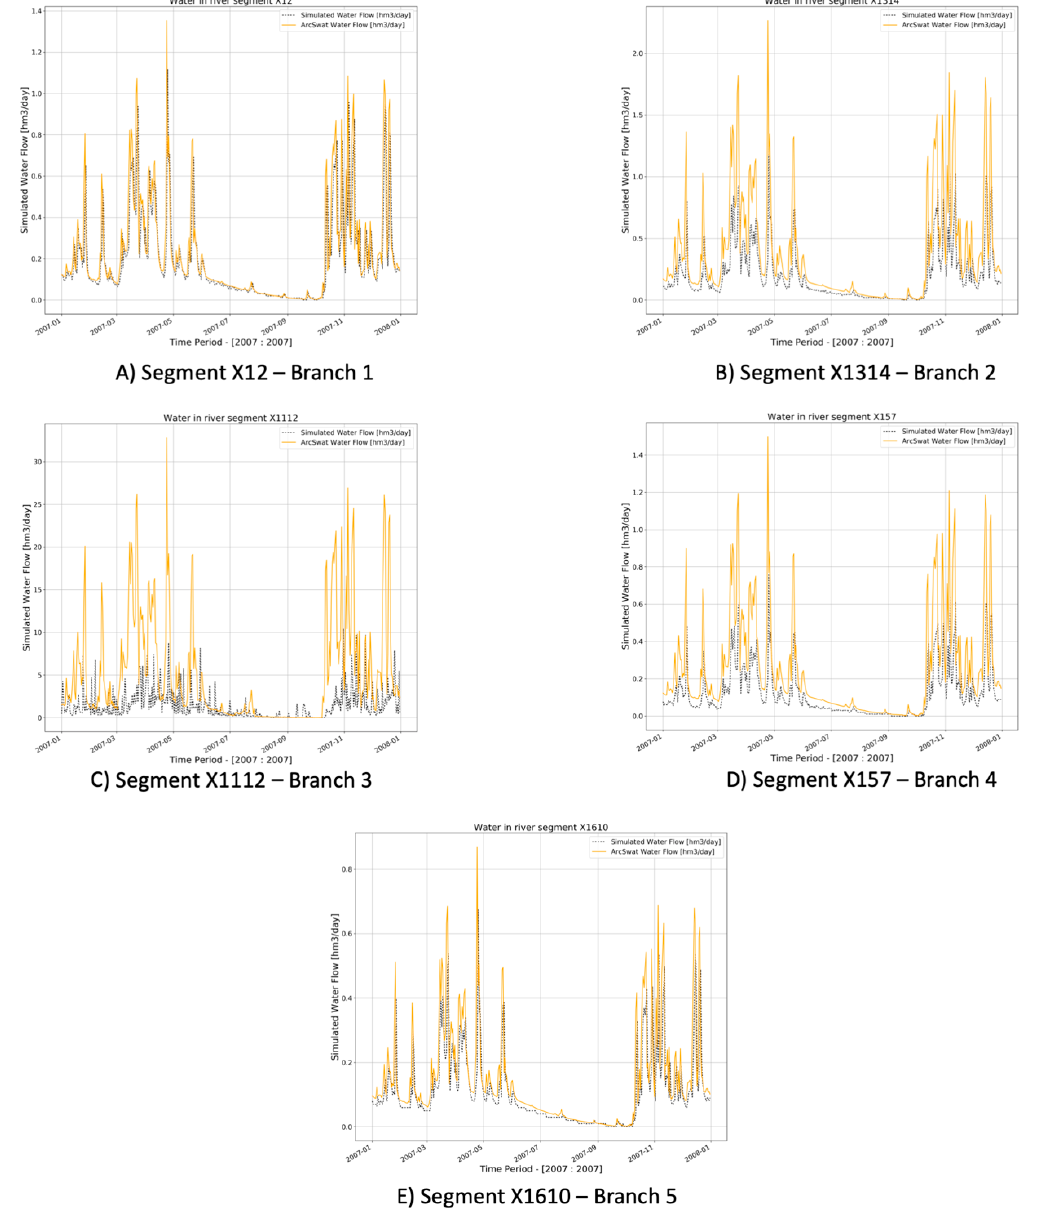
Figure 11. The comparison of the water flow as simulated by the calibrated LP-model and the